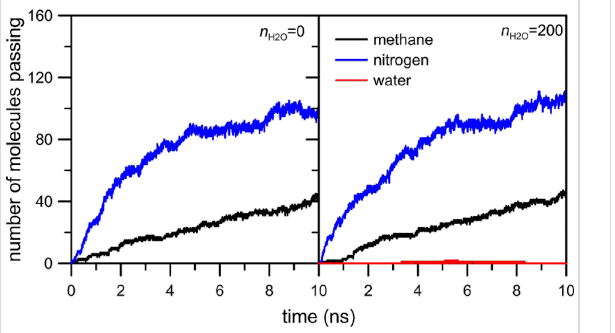
2.5 nm from the rim the cumulative number of water